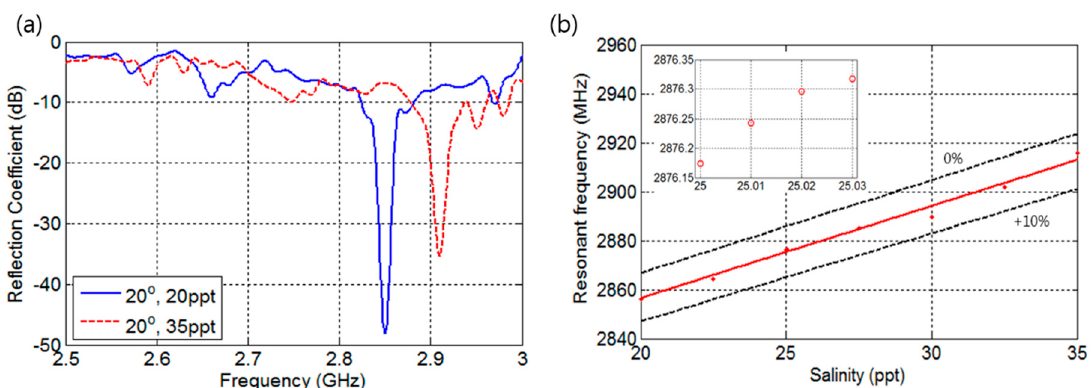
Figure 9. Experimental results: ( a ) Reflection coefficients of the proposed sensor; ( b ) Resonant frequency according to salinity.